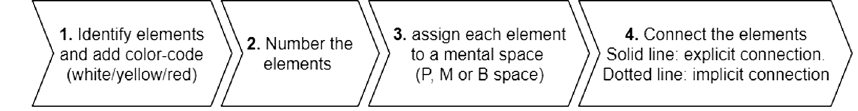
FIG. 8. Schematic overview of the necessary steps to construct a